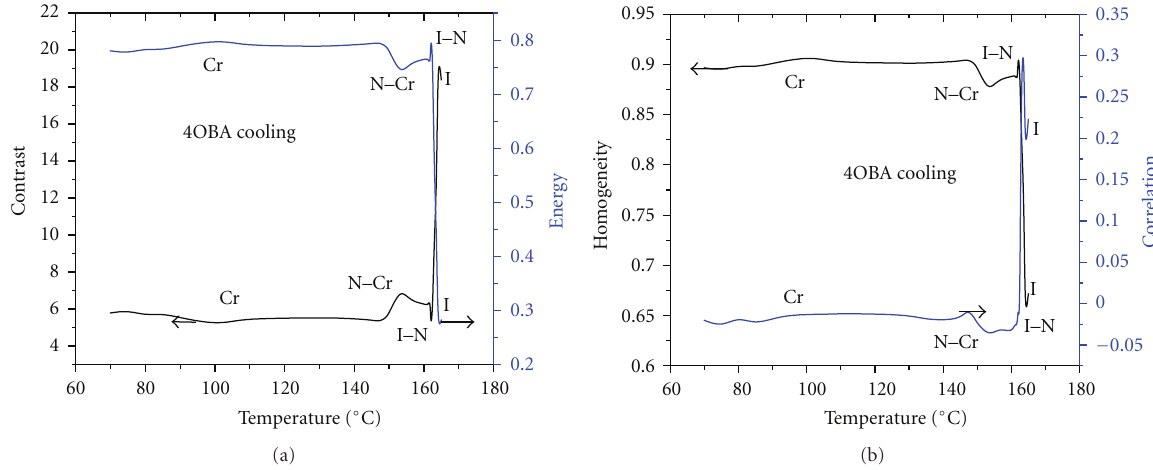
Figure 5: Computed parameters from the textures of 4OBA as a function of temperature where the phase transitions are indicated. (a) Contrast and energy; (b) homogeneity and correlation. Cr: Crystal, SmC: SmecticC, N: Nematic, and I: Isotropic.